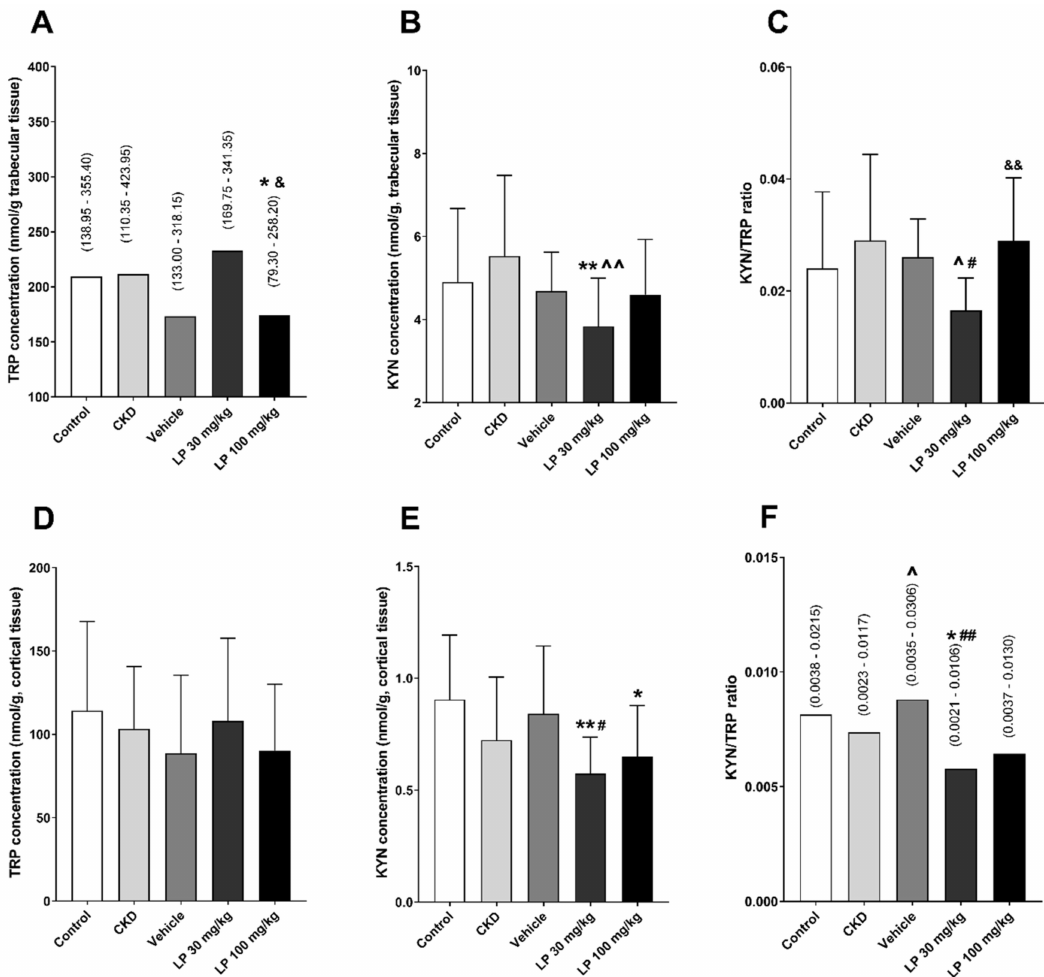
Figure 2. Changes of tryptophan (TRP) and kynurenine (KYN) concentrations, and KYN / TRP ratio among experimental groups in the femoral trabecular ( A – C ) and cortical ( D – F ) bone regions. Data are shown as median and range ( A , F ) or mean ± SD ( B – E ). * p < 0.05, ** p < 0.01, control vs. others; ˆ p < 0.05, ˆˆ p < 0.01 CKD vs. others; # p < 0.05, ## p < 0.01, vehicle vs. others; & p < 0.05, && p < 0.01, LP 30 mg / kg vs. LP 100 mg /